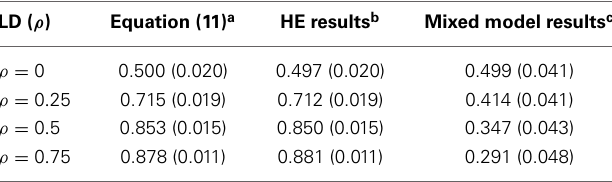
Table 11 | Simulation evaluations of Equation (11) when the covariance summation is not zero ( (cid:4) (cid:2)= 0). LD ( ρ ) Equation (11) a HE results b Mixed model results